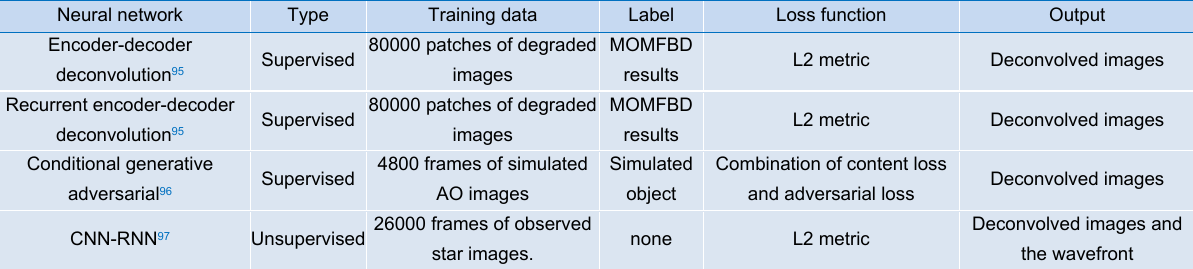
Table 7 | The general information and differences of all the four